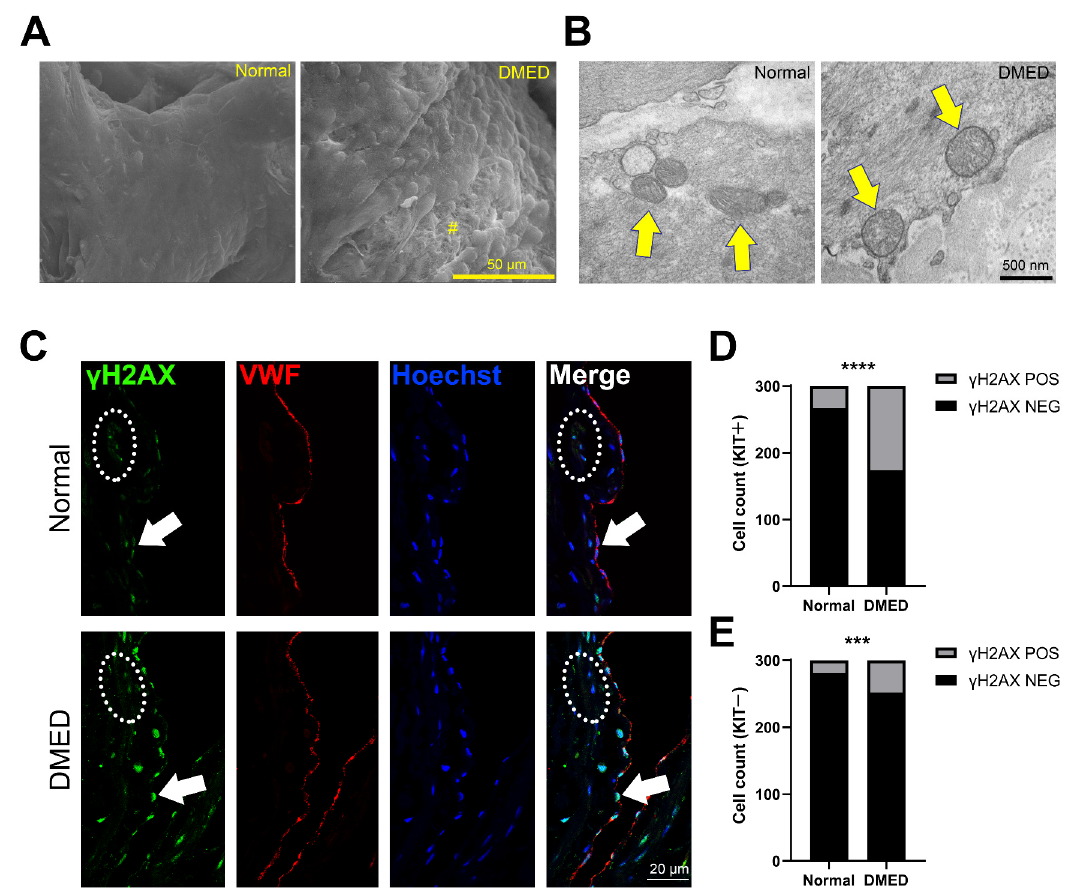
Figure 1. The pathological change of CCECs in DMED patients. ( A ) Scanning electron microscope image of normal and DMED cavernosal trabecular endothelium. The scale bar represents 50 µ m. “#” labeled the region where the endothelium is detached. ( B ) Transmission electron microscope image of normal and DMED CCECs. Mitochondria are marked by yellow arrows. The scale bar represents 500 nm. ( C ) Immunofluorescence co-staining of VWF (red) and γ H2AX (green) in CC paraffin sections. The white arrows point to γ H2AX and VWF double-positive CCECs, and VWF- negative non-endothelial cells are marked in the dotted box. The scale bar represents 20 µ m. ( D , E ) The statistical analysis of the γ H2AX positive and negative ratio in CCECs ( D ) and other CC somatic cells ( E ). ***, p < 0.001; ****, p < 0.0001. n = 300 cells from 5 normal CC samples and 300 cells 2 DMED CC samples. DMED: Diabetes mellitus-induced erectile dysfunction; CCEC: corpus cavernosum endothelial cells.